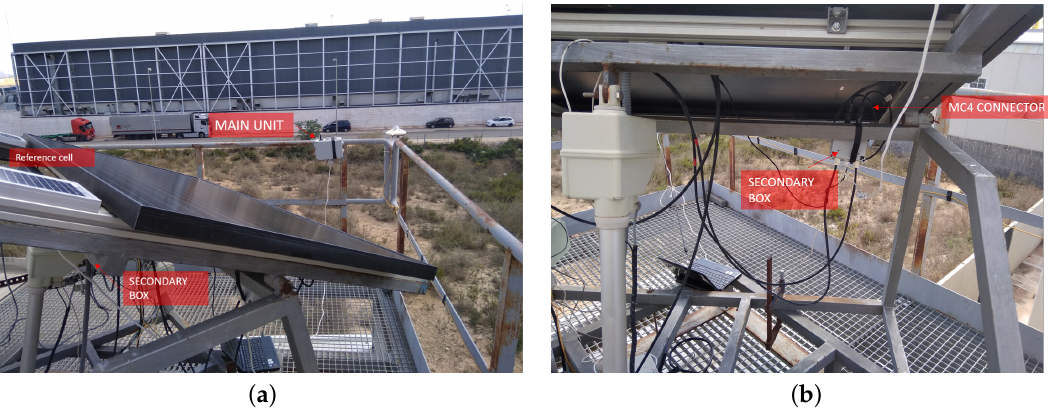
Figure 6. Testing system located at the CETENMA SolarLab (Spain). ( a ) SolarLab outdoor test site details. ( b ) Secondary box